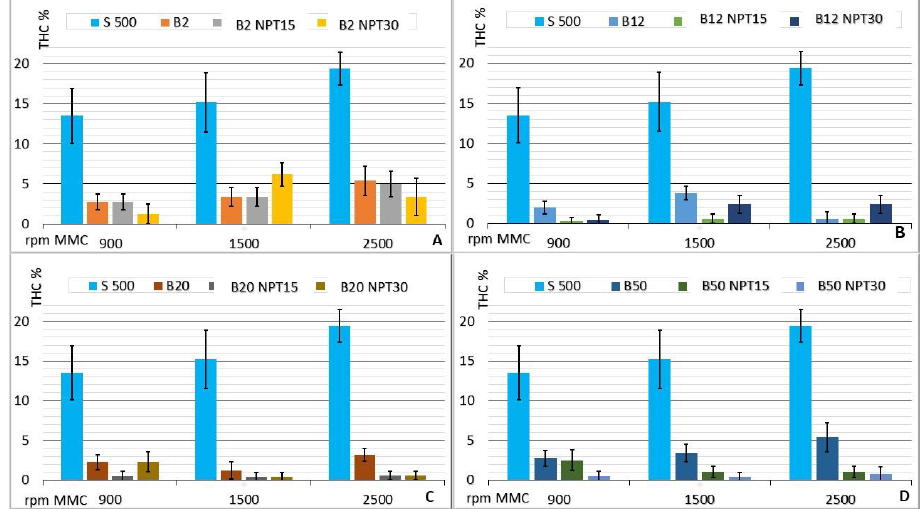
Figure 7. Emissions of THC (% v / v ) from the CCE running on the biodiesel:diesel mixtures in the proportions of 2% ( A ); 12% ( B ); 20% ( C ); and 50% ( D ) biodiesel obtained by CC, B100-NTP15, B100-NTP30, and S-500 at different engine speeds (rpm).